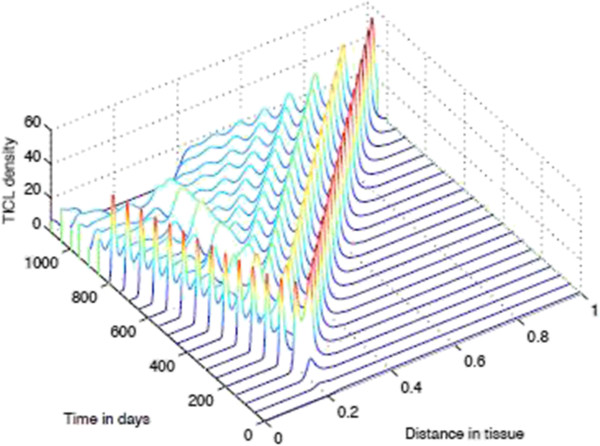
Time-slices of CTLs in presnece of immunoevasion. Plots showing detailed changes in the spatial distribution of CTLs within the tissue over time in the case of immunoevasion. Parmeter values pN=0.75 and ki+=constant.